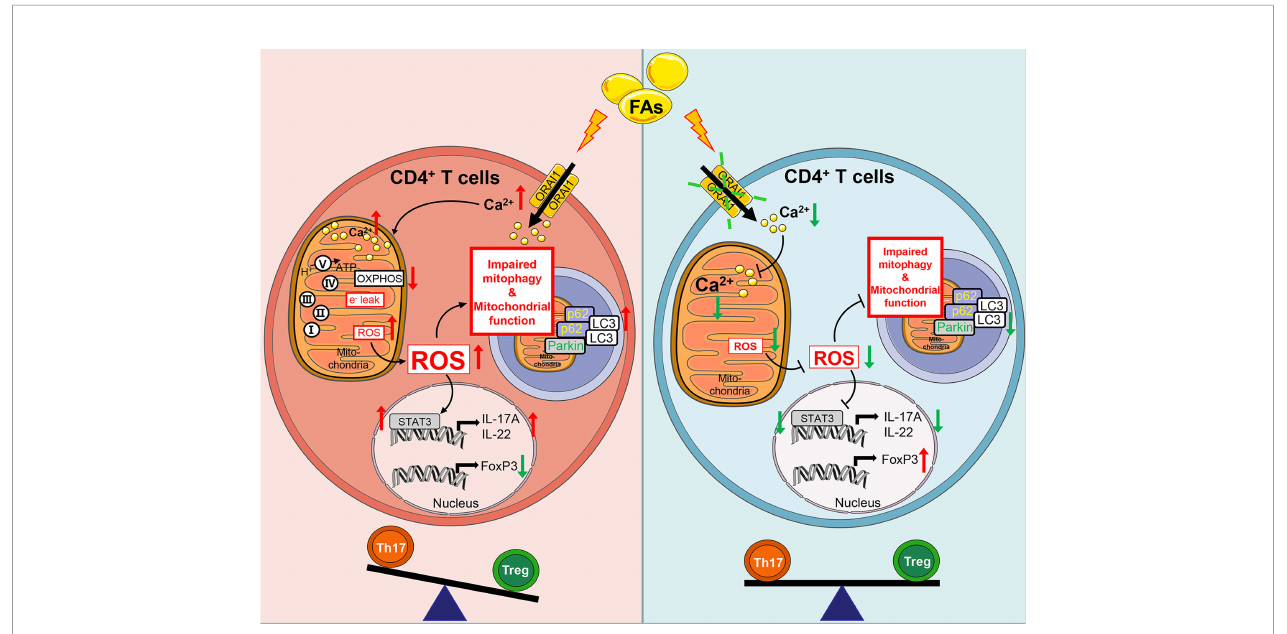
FIGURE 12 | Schematic picture showing Fatty acids impact adaptive immunity negatively through ORAI1 regulated intracellular Ca 2+ , ROS balance, and increased effector functions of Th17 cells in CD4 + T cells from cows. Brief in description: Left hand panel. Fatty acids induced ROS production through activated ORAI1. High levels of ROS increased electron leak and mitochondrial membrane permeability to damage mitochondrial function. High levels of ROS increased the protein abundance of Parkin, p62 and LC3 abundance to impair mitophagy and cause accumulation of mitophagy intermediates. Damaged mitochondrial function and impaired mitophagy led to more generation of ROS. ROS increased IL-17A expression and decreased FoxP3 expression by activating STAT3, thus inducing an imbalance between Th17/Treg cells. Right hand panel. Under conditions of fatty acid stimulation, silencing or inhibition of ORAI1 could alleviate the Th17/Treg cells imbalance by downregulating the level of Ca 2+ and ROS in both mitochondria and cytoplasm.